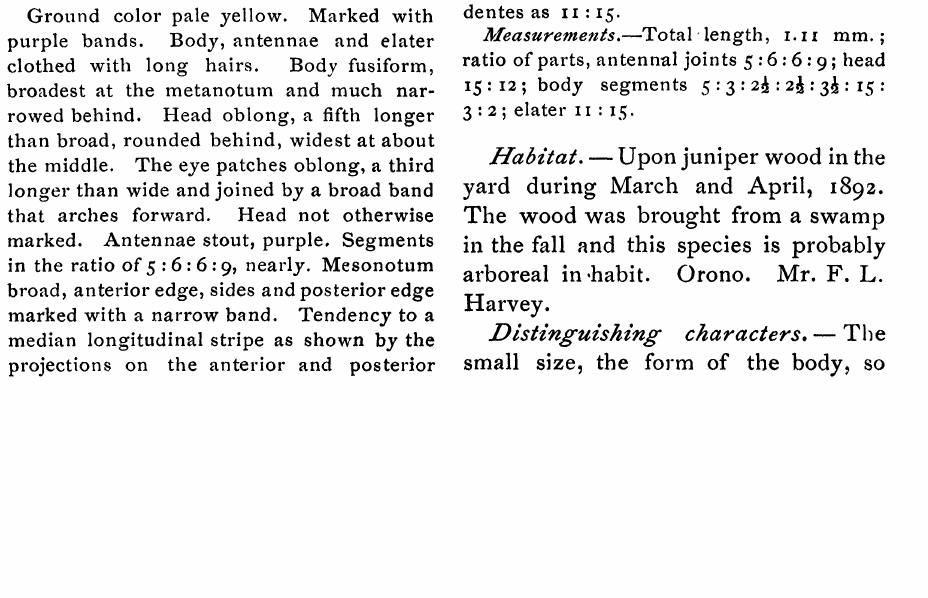
. Fig. Entornobrya pygmaea. Legs and elater light colored. The latter slender. Manubrium to mucrones and dentesas